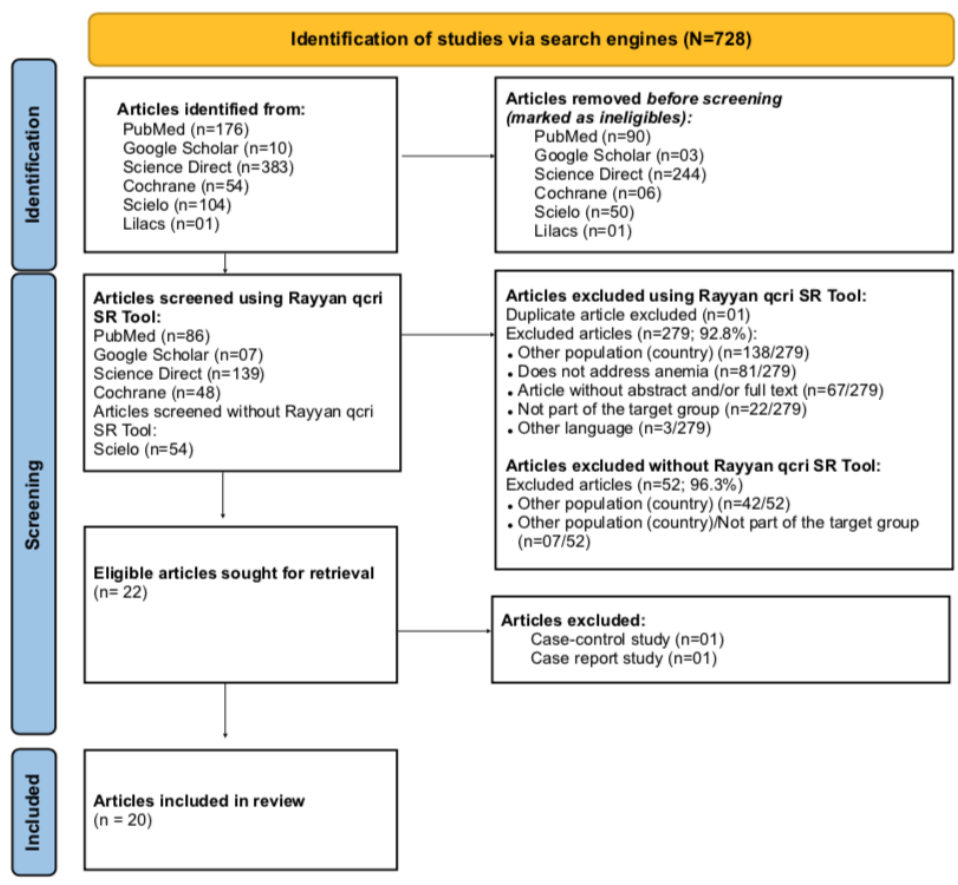
Figure 1. PRISMA flow chart describing selection of articles for review on anemia in pregnant women and children aged 6 to 59 months living in Mozambique and Portugal.